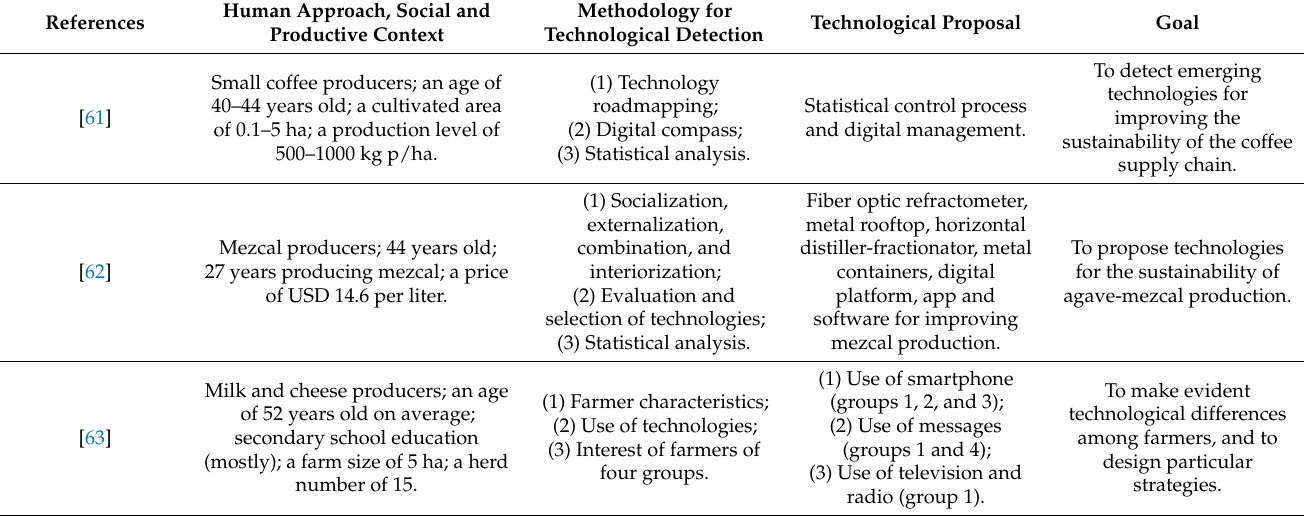
Table 1. Technologies introduced with a human